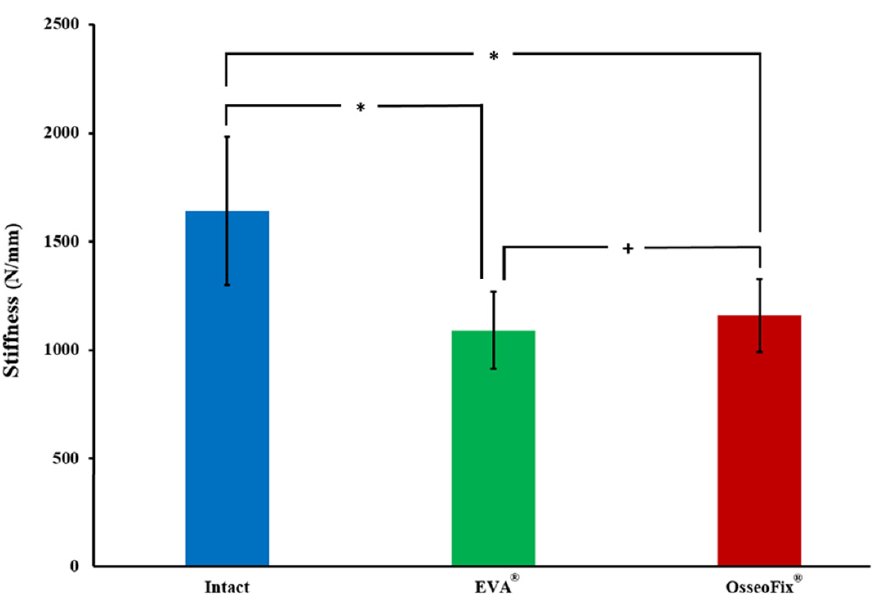
Figure 8. Mean stiffness in the intact, EVA® and OsseoFix® groups. Groups with significant differ- ences ( p < 0.05) are indicated with the “*” symbol.